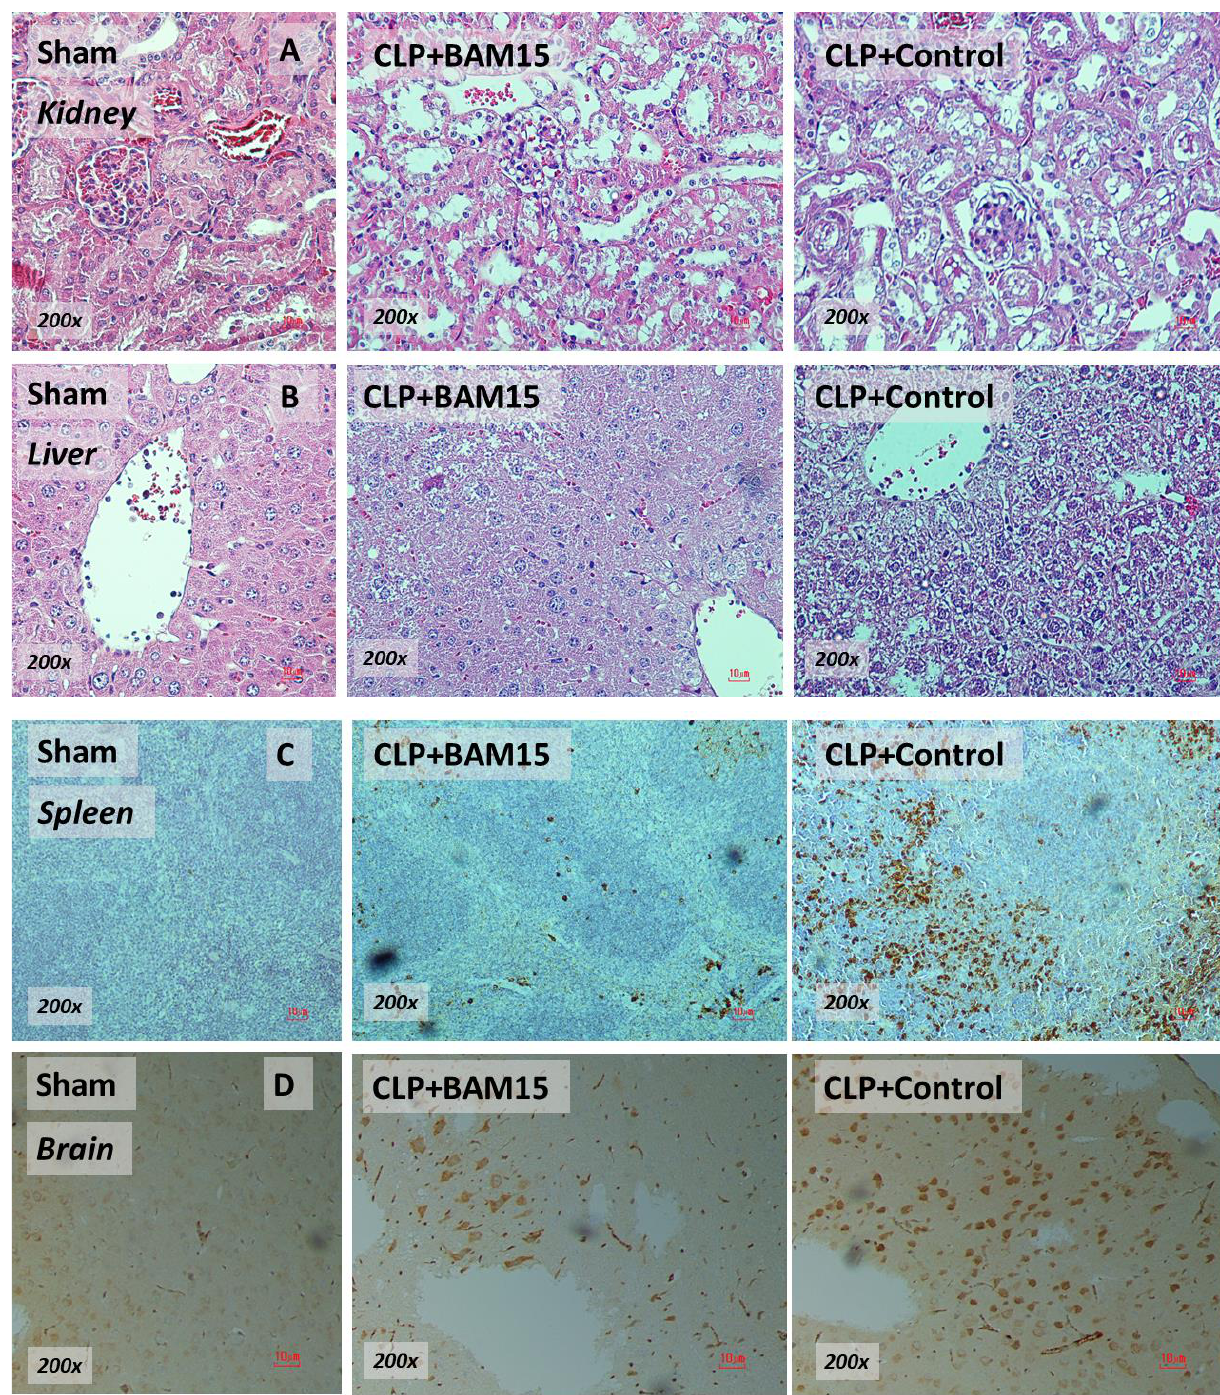
Figure 2. Representative pictures of Hematoxylin and Eosin (H&E) staining (kidneys and livers) ( A , B ) and activated caspase 3 immunohistochemistry (apoptosis) (spleen and brain) ( C , D ) of cecal ligation and puncture (CLP) sepsis or sham mice at 24 h after surgery with BAM15 or vehicle (control) are demonstrated. The pictures from sham mice with BAM15 are not shown due to the non-significant difference to the sham group.